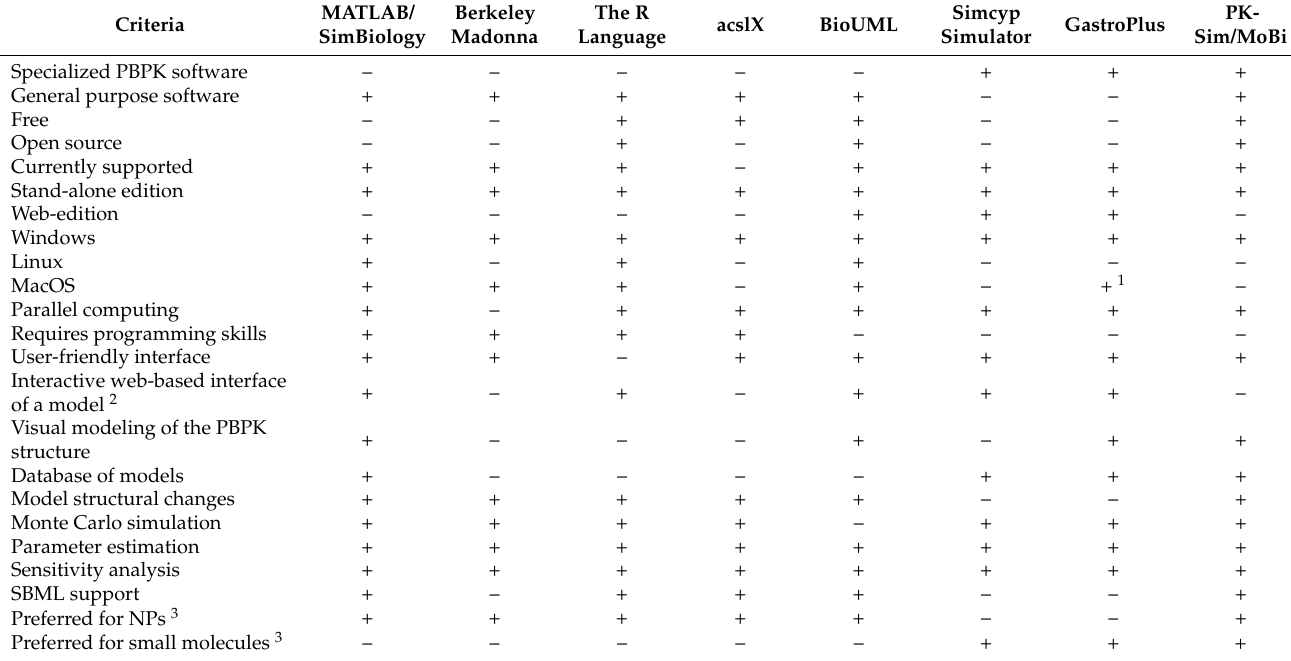
Table 1. Comparison of software packages for PBPK modeling of